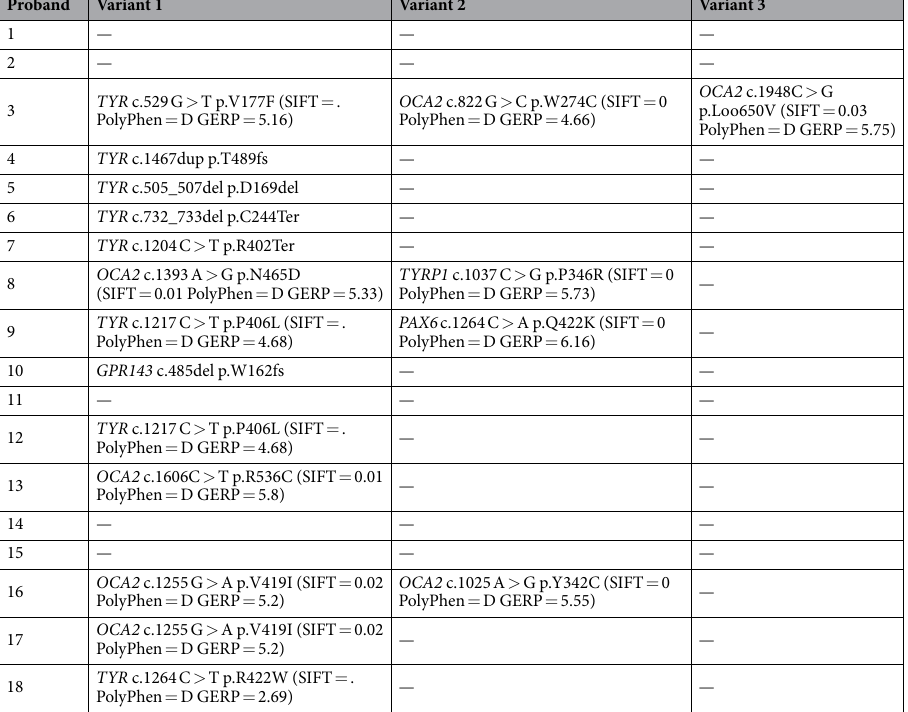
— Table 2. Predicted causal variants, in eighteen probands with phenotypes matching hypomorphic albinism. Pathogenicity determined by filtering all variants in the genes; TYR , OCA2 , TYRP1 , SLC45A2 , SLC24A5 , C10orf11 and PAX6 , with the parameters MAF < 0.05, SIFT < 0.05, PolyPhen2 = possibly damaging or probably damaging. The prediction scores for non-synonymous variants are included, for some mutations a prediction score was not available at the time of analysis. Gene accessions number: TYR NM_000372,